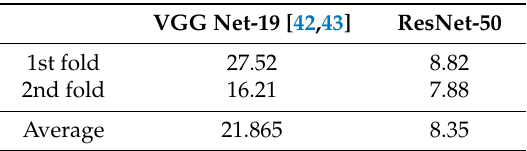
Table 6. Comparisons of EERs by VGG Net-19 and ResNet-50 for body recognition (unit: %).